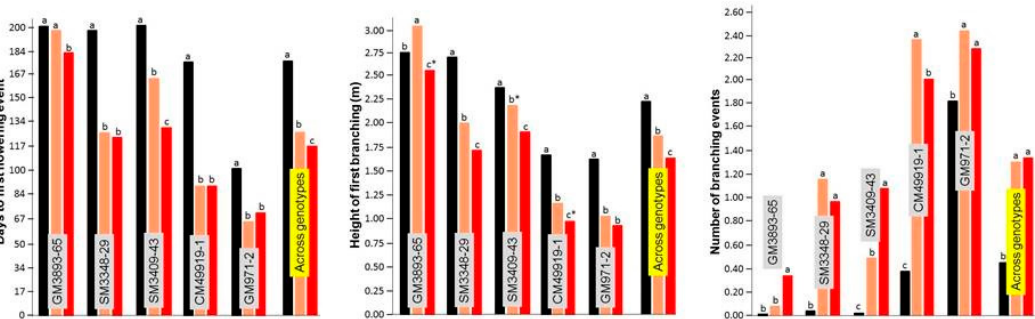
Figure 2. Averages for days to 1st flowering, height of 1st branching and number of branching events in five genotypes and across genotypes grown under normal photoperiod (black bars), and extended photoperiod based on low (pink bars) and high (red bars) light intensity. The comparison in individual genotypes and across genotypes with different letters, are statistically significant at p < 0.01 (except cases identified with an asterisk where differences were significant at p < 0.05). The statistical significances were derived from the analysis of variance presented in Table 2. * Differences were statistically significant at p < 0.05.